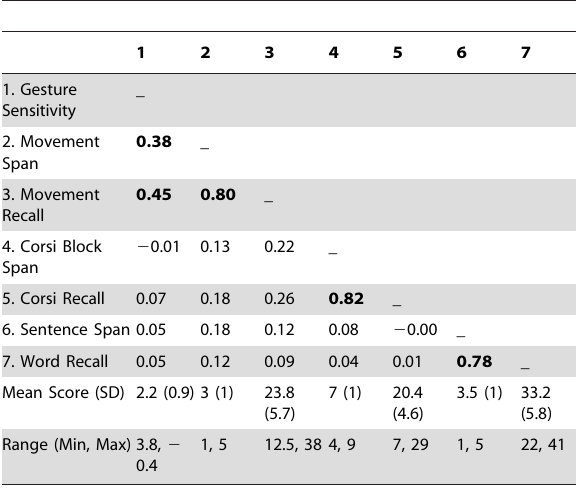
Table 1. Zero-order correlations and descriptive statistics for scores on the span and gesture classification